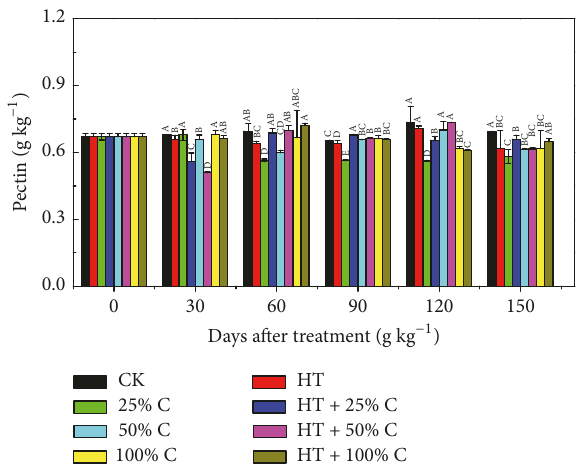
Figure 4: Effects of combined heat and preservative treatments on pectin content in the fruit peel during storage. The error bars represent the standard errors. “C” represents the concentration of preservative used in production. Different superscripts between columns represent significant differences between samples at the 0.05 level.